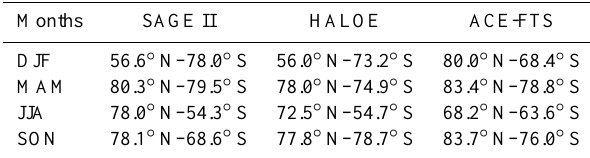
Table 1. Latitude ranges for all collocations with SCIAMACHY for each season and instrument in the years 2003 and 2004 (2004 and 2005 for